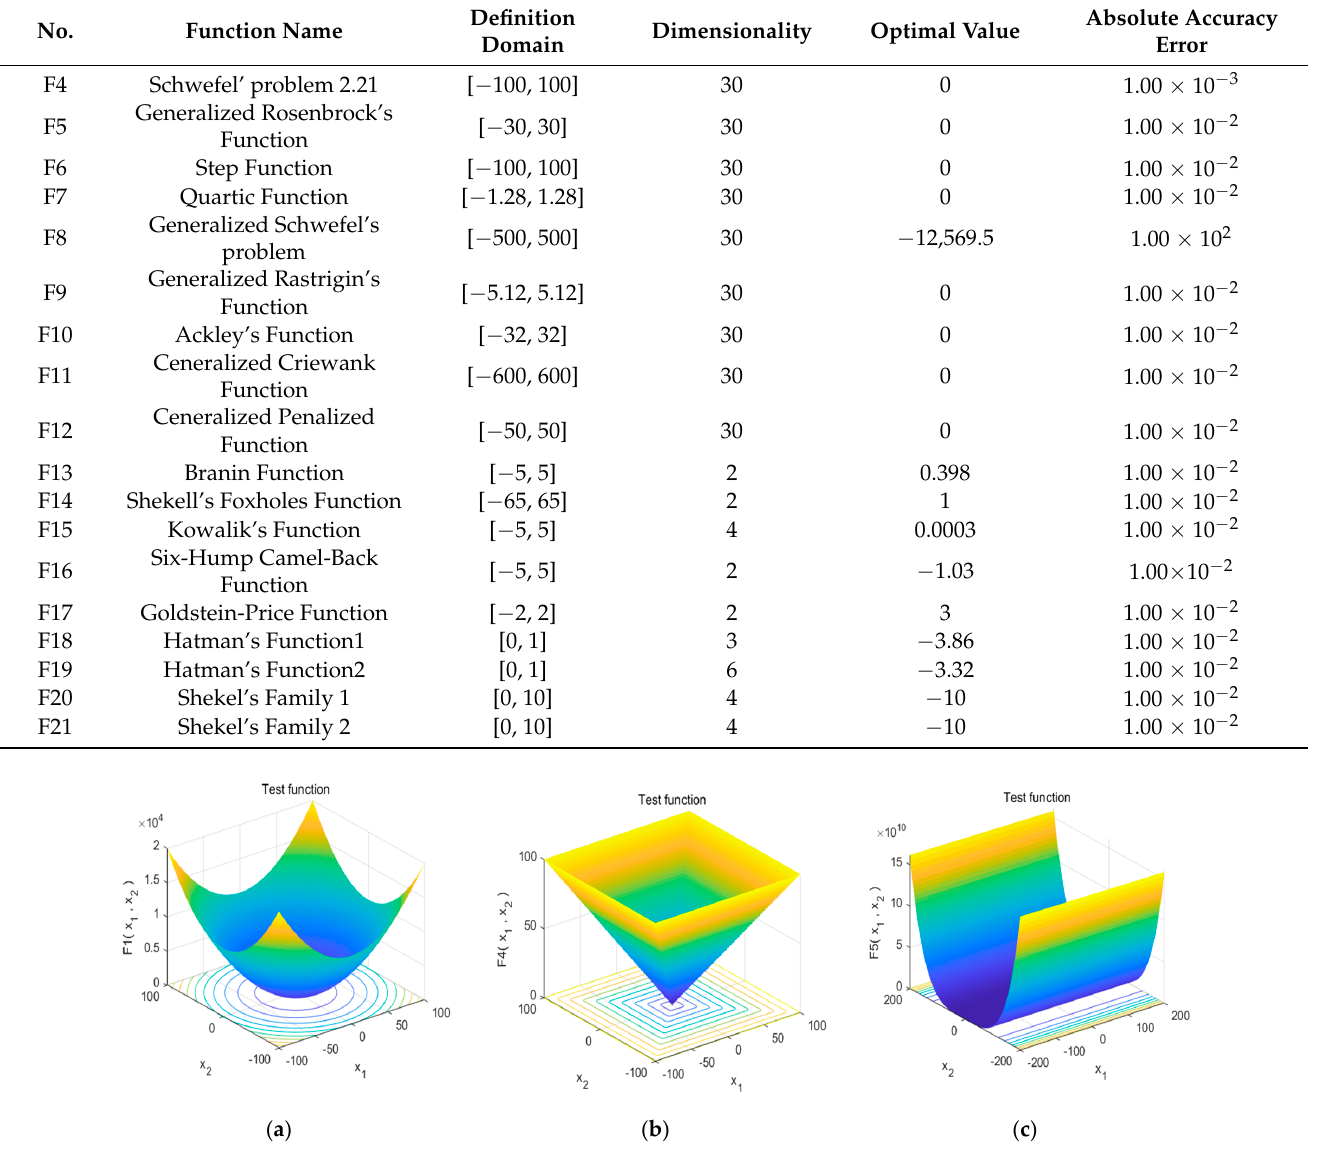
( c ) Figure 9. Distribution diagram of different fixed multimodal test function values. ( a ) F14 function; ( b ) F16 function; ( c ) F19 function. 4.3. Comparison of the IMSChoA Algorithm with Other Algorithms Twenty-one basic test functions are selected to perform the optimization search test for the algorithm mentioned in the summary of 4.1, and the iteration curves are shown in Figure 10. Among them, F1~F7 are continuous unimodal test functions with only one global optimum and no local optimum, which are used to test the global search ability and convergence speed of the algorithm. From Figure 10a–g, it can be seen that the IM- SChoA optimization algorithm has a fast convergence speed and strong global search ca- pability, which is faster and stronger than other group intelligence optimization algo- rithms in terms of iteration speed and preliminary global search capability. F8~F13 are continuous multimodal test functions with multiple local optima, which are used to test the ability of the algorithm to jump out of the local optimum. From Figure 10h–l, it can be seen that the IMSChoA optimization algorithm falls into the local optimum when calcu- lating F8, F9, F11, and F12 functions, but it quickly jumps out of the current state and continues to search for the optimal iteration, which proves that the IMSChoA optimiza- tion algorithm has a strong ability to jump out of the local optimum, which is further im- proved compared with the ChoA optimization algorithm. F13~F21 are fixed multimodal test functions, which are used to test the equilibrium development capability and stability of the system. As can be seen from Figure 10m–u, the IMSChoA optimization algorithm can well balance the iterative ability of the algorithm and quickly complete the optimiza- tion search test, and the algorithm has significantly improved in terms of convergence